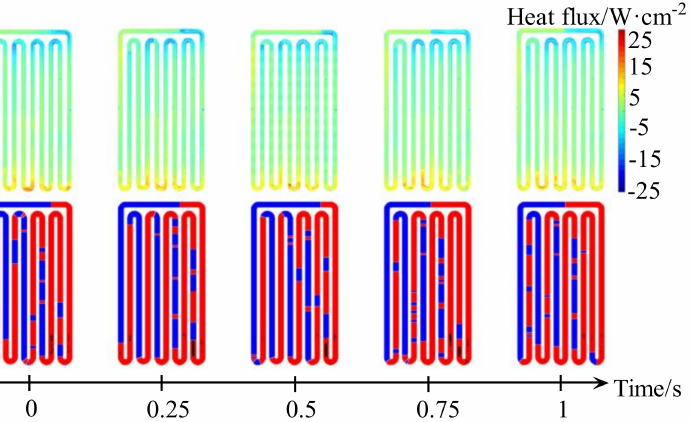
Figure 15. Time-resolved distribution and flow visualization of heat flux with input power of 16 W [221]. Jung et al.,